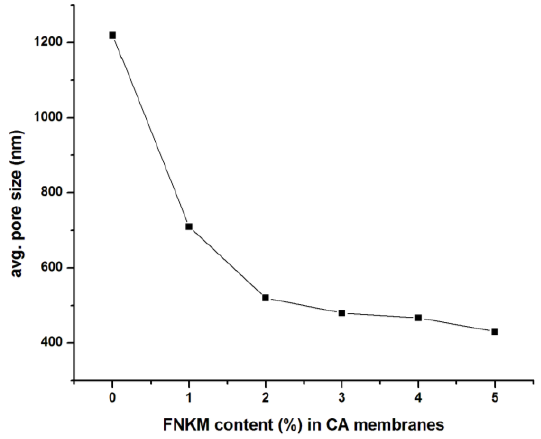
Figure 2. Correlation between FNKM content (%) loading in CA membranes and average (avg.) pore size.